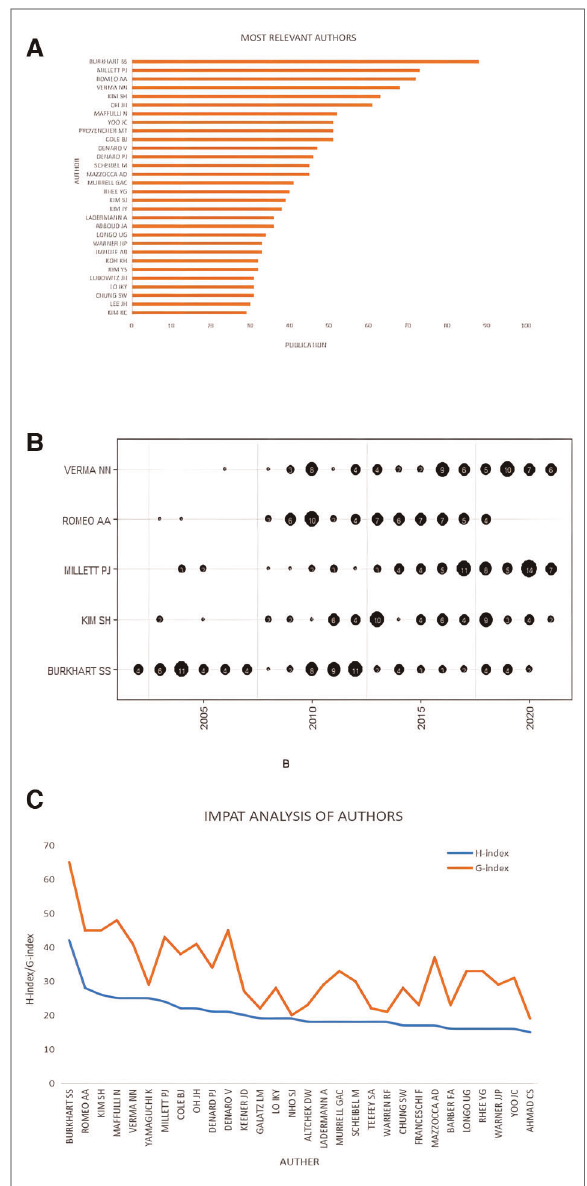
( Figure 6A ). The dynamic growth of the frequency of FIGURE 4